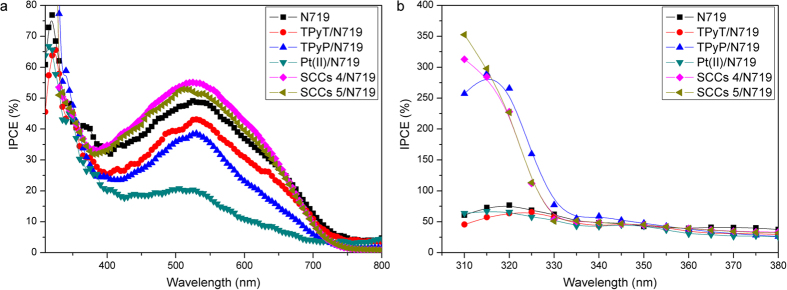
IPCE spectra recorded by using ligands or SCCs and dye co-sensitized TiO2 photoanodes.